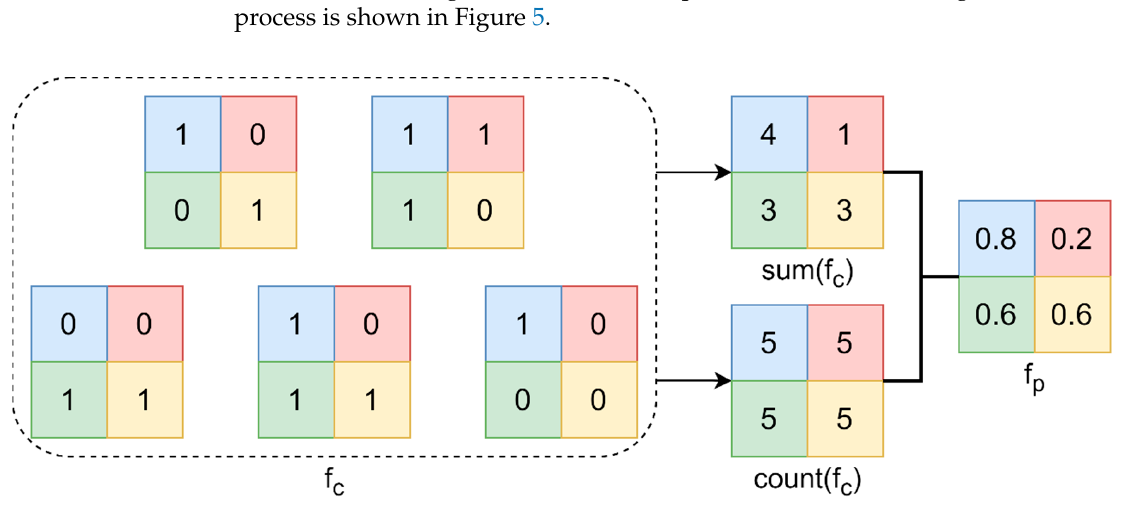
Figure 4. Comparison of different extraction results produced by the canny operator under four different threshold set ‐ tings. ( a ) edge extraction results when the threshold is 0; ( b ) edge extraction results when the threshold is 1; ( c ) edge extraction results when the threshold is 2; and ( d ) edge extraction results when the threshold is 3.